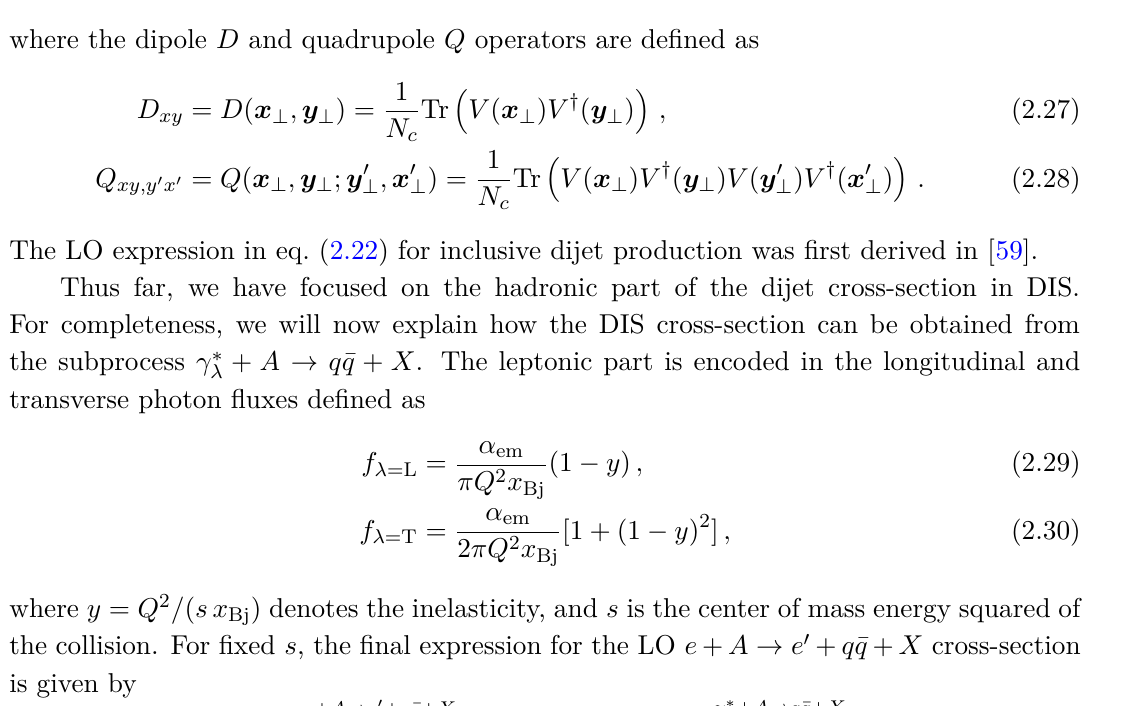
= O (1 /g ) of the nucleus shown on the r.h.s. cl